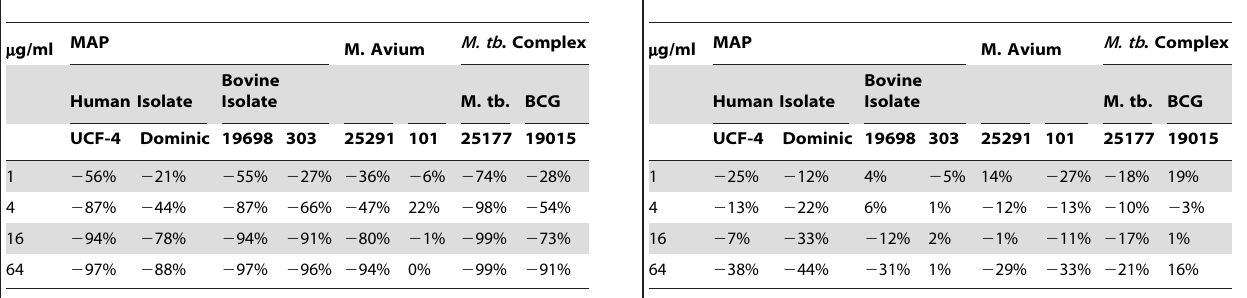
Table 1. Monensin Inhibitory Control.